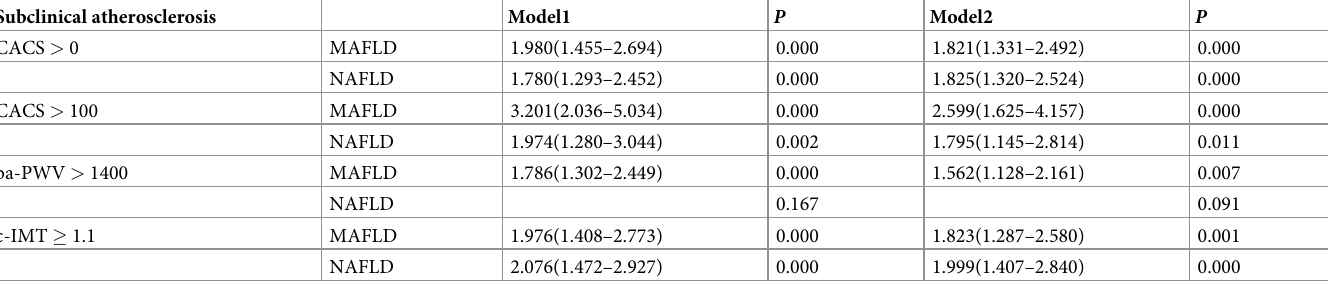
Table 2. The association of subclinical atherosclerosis with presence of MAFLD or NAFLD. Subclinical atherosclerosis